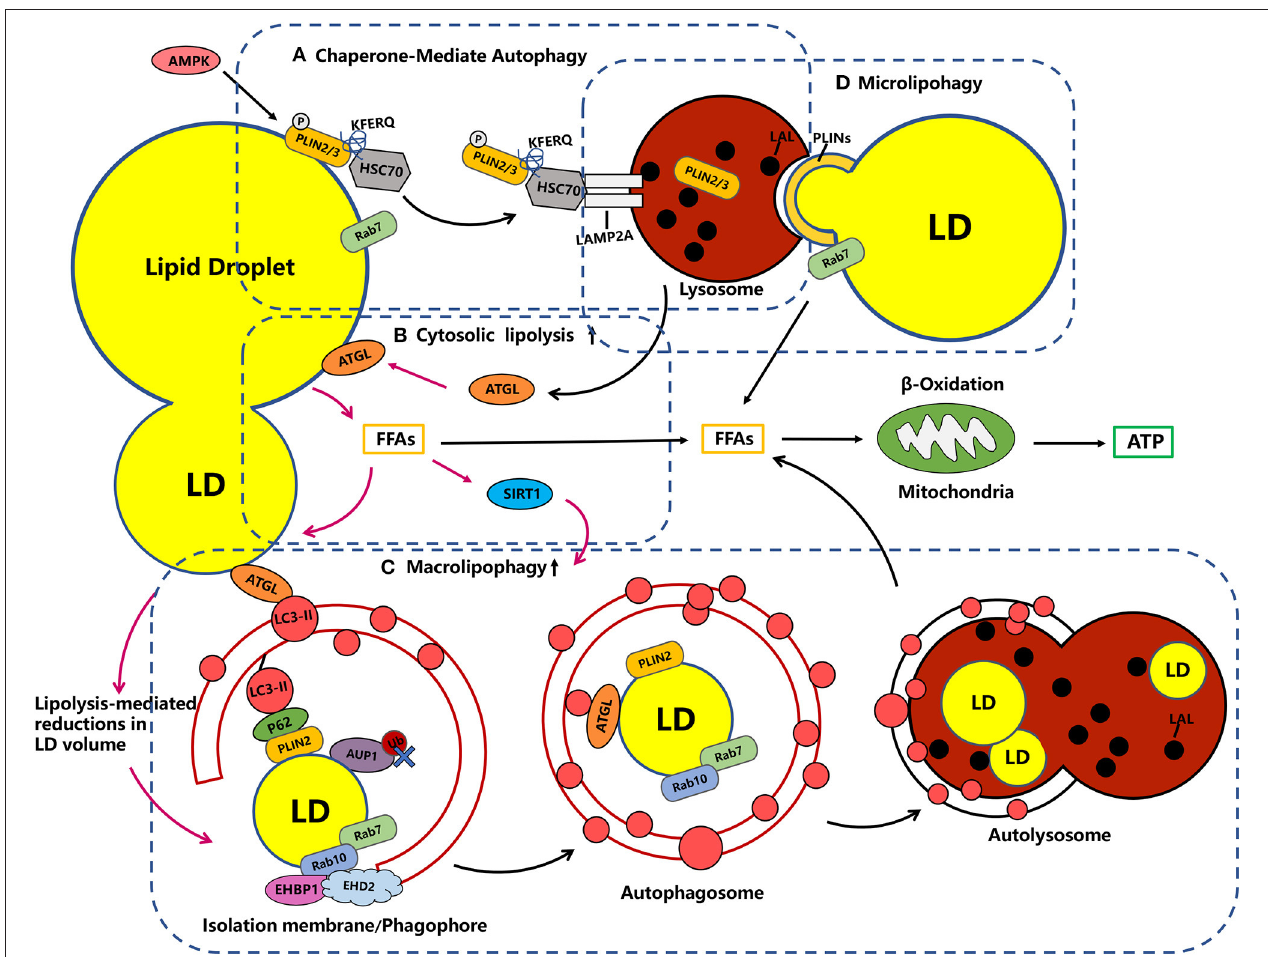
FIGURE 1 | Crosstalk in the metabolic machinery of LDs. (A) Chaperone-Mediate Autophagy (CMA). LDs catabolism early degrades PLIN2 through CMA, a process that is important for the recruitment of ATGL and autophagic membranes to LDs. In the CMA, PLIN2/3 proteins, which normally coat the LDs and block access to neutral lipases, are phosphorylated (P) by AMPK and tagged by the adapter HSC70, which promotes LAMP2A-mediated translocation into the lysosome. Rab7 has also been implicated in the formation of LD–lysosome contacts and the transfer of PLIN2 from LDs to lysosomes. (B) Cytosolic lipolysis: ATGL targets large LDs upstream of lipophagy, which is restricted to small LDs, and releases fatty acids that can be re esterified and packaged into small LDs. Besides, the ATGL has been shown to be a necessary and sufficient positive regulator of lipophagy induction acting through the deacetylase SIRT1, suggesting tight co-ordination between two lipolytic pathways (note with pink one-way arrow). (C) Macrolipophagy: Autophagosomes engulf small LDs or engulf part of large LDs. The recruitment of autophagosome membranes can be mediated LC3-interacting regions (LIR)-containing adapter proteins, such as P62, one possible candidate for a lipophagy receptor, as it associates with LDs by interaction with PLIN2 and is required for lipophagy. Rab7 dependent rab10 and its complex EHBP1-EHD2 are required for the recruitment of LC3-positive autophagic membranes to LDS, which together could drive the extension of the autophagosome membrane around the LDs for engulfment. (D) Microlipophagy: microlipophagy reflects the direct and transient interactions of lysosomes with LDs as a means to degrade LD-derived lipids. The LD-lysosome contacts may be relevant for PLINs, while there is currently a lack of evidence demonstrating microlipophagy in mammalian